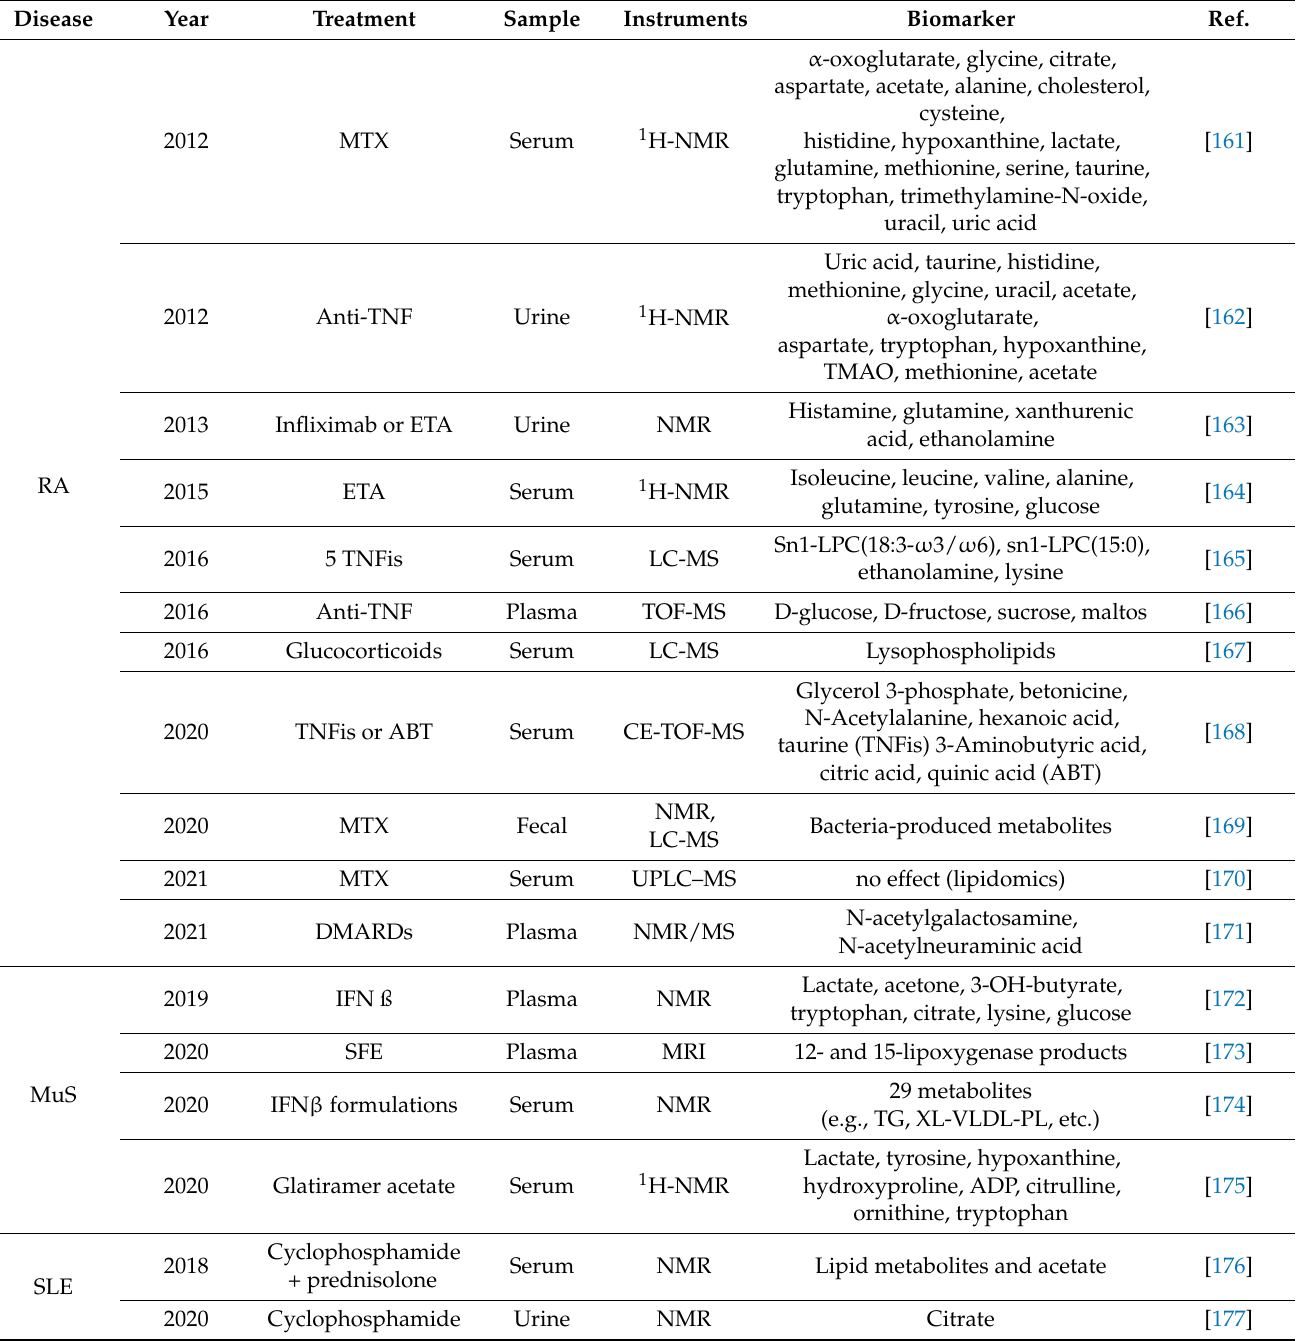
Table 4. Relevant potential biomarkers for AD treatment outcome prediction identified through a metabolomics approach.